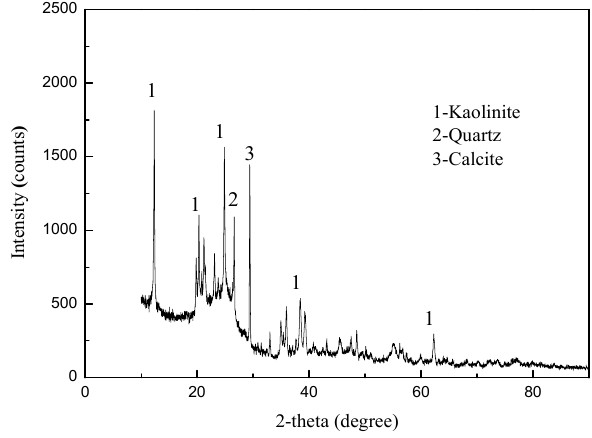
Figure 1. XRD patterns of the coal sample.